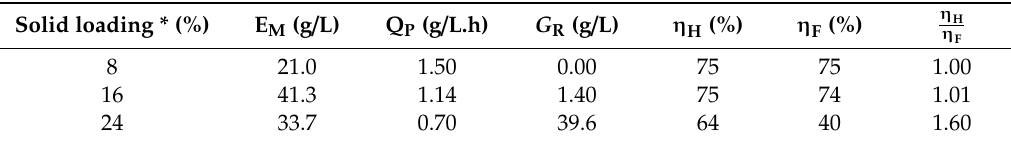
Table 7. Parameters of the batch SSF in the VBM reactor under the di ff erent solid loadings of pre-treated rice